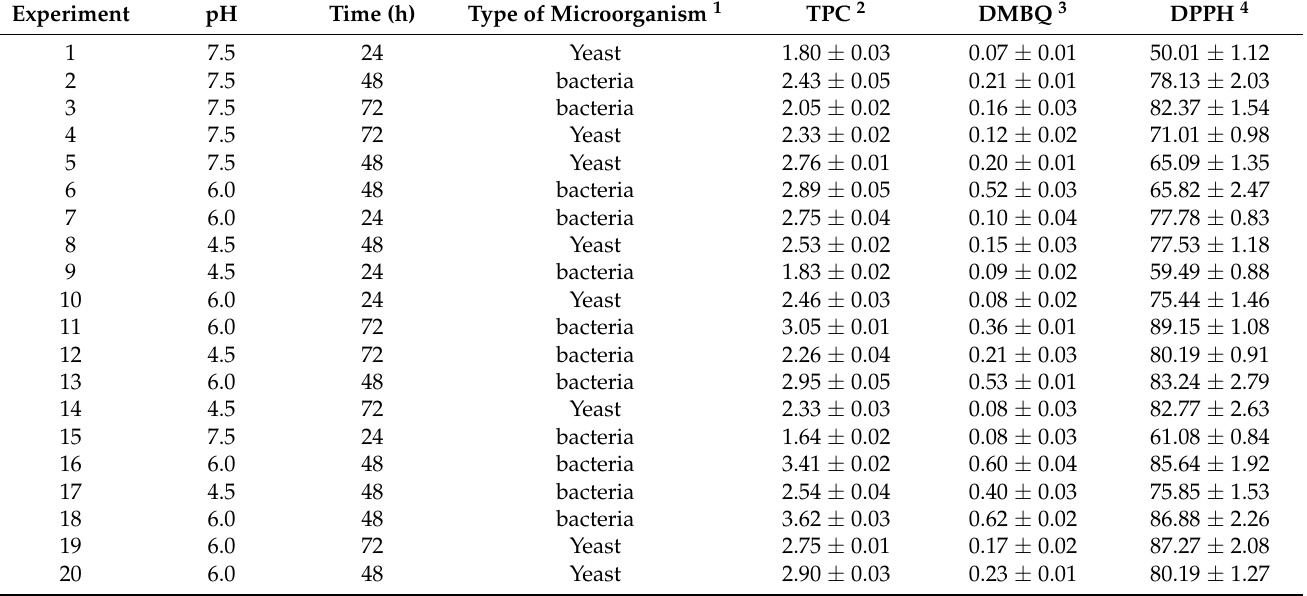
Table 1. Matrix of experimental design defined by central composite design for the optimization of the process of fermentation of wheat germ. The main experimental responses (total phenolic content (TPC), dimethoxy benzoquinone (DMBQ) and 1,1-diphenyl-2-picrylhydrazyl (DPPH) radical scavenging activity) are expressed as average ± standard